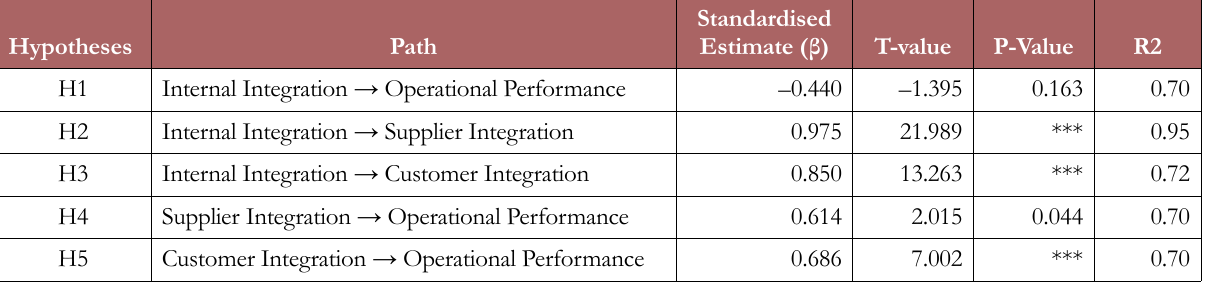
Table 4. Path analysis